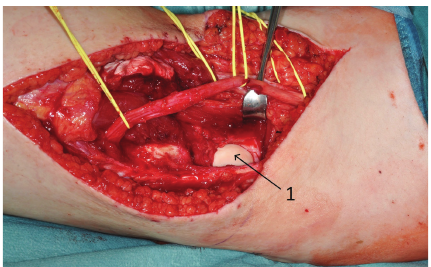
Figure 4: Intraoperative picture: 1 dorsal aspect of condylus later- alis.